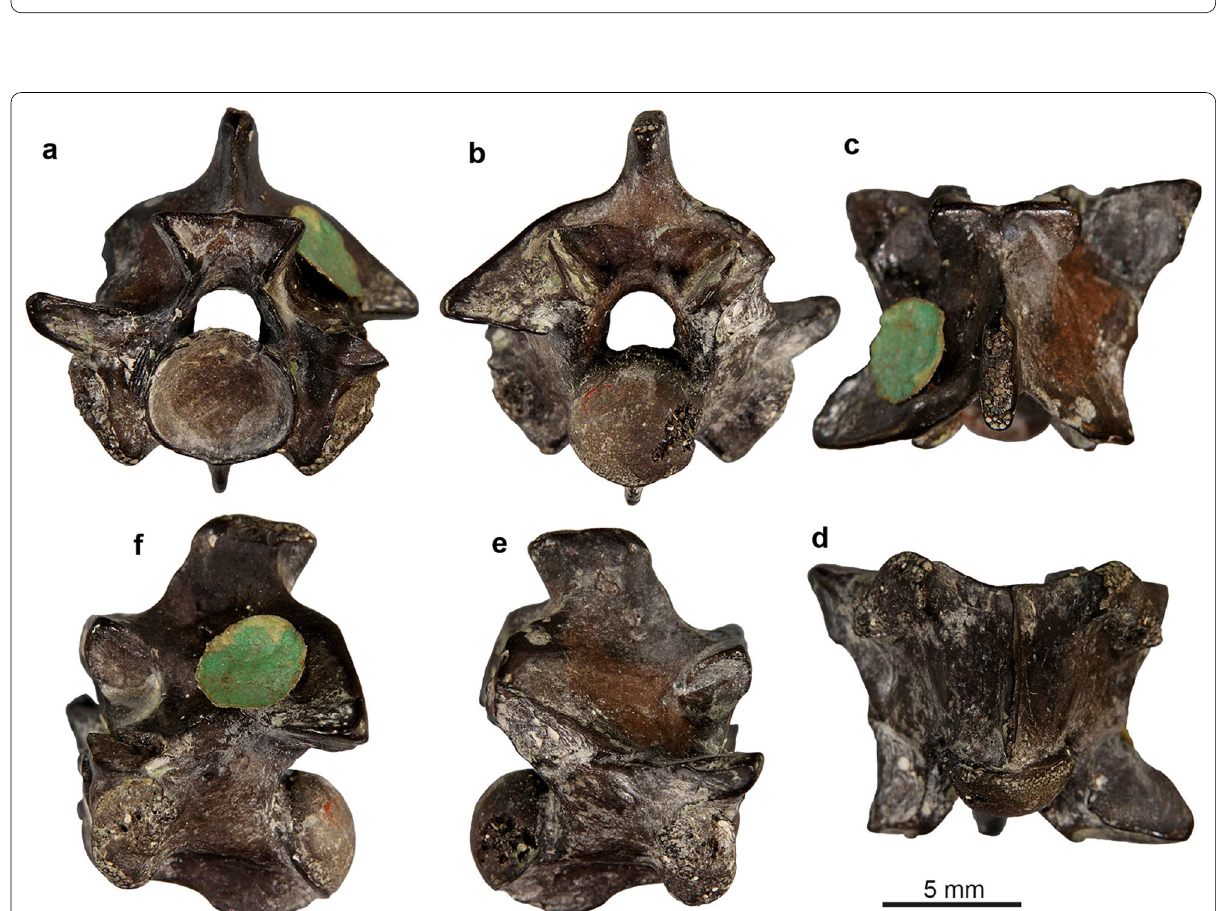
Fig. 33 Original lithograph of the type material of Paleryx rhombifer (holotype, NHMUK PV OR 25259 ( a – d ) and Paleryx depressus (lectotype [herein designated], NHMUK PV OR 25261(1) ( e , f ). Image modified from plate XIII of Owen (1850)